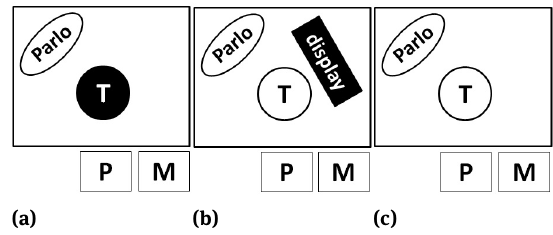
Fig. 13. The arrangement of experimental environment. (a) Scenario with illuminated half-sphere; (b) scenario with changing colour of the circle on the computer screen; (c) scenario with only verbal notification. T: Touch Ball, P: Participant, M: Moderator